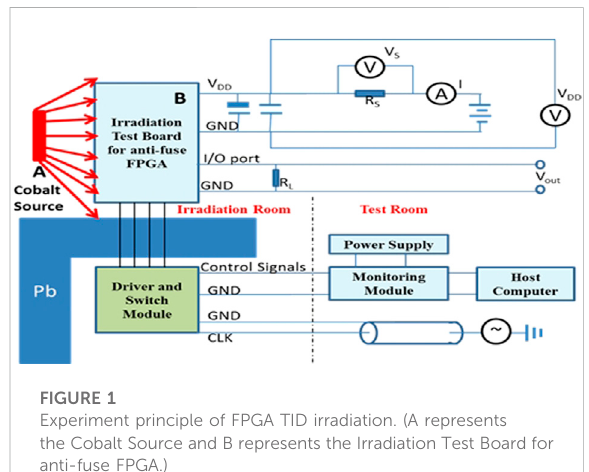
FIGURE 1 Experiment principle of FPGA TID irradiation. (A represents the Cobalt Source and B represents the Irradiation Test Board for anti-fuse